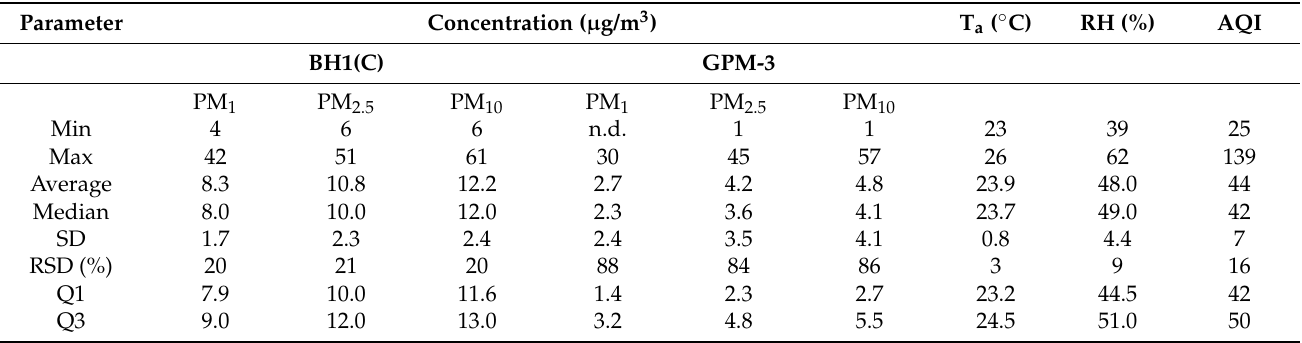
Table 4. Statistics of air monitoring data for GPM-type and BH1 sensors collected indoors (ante-